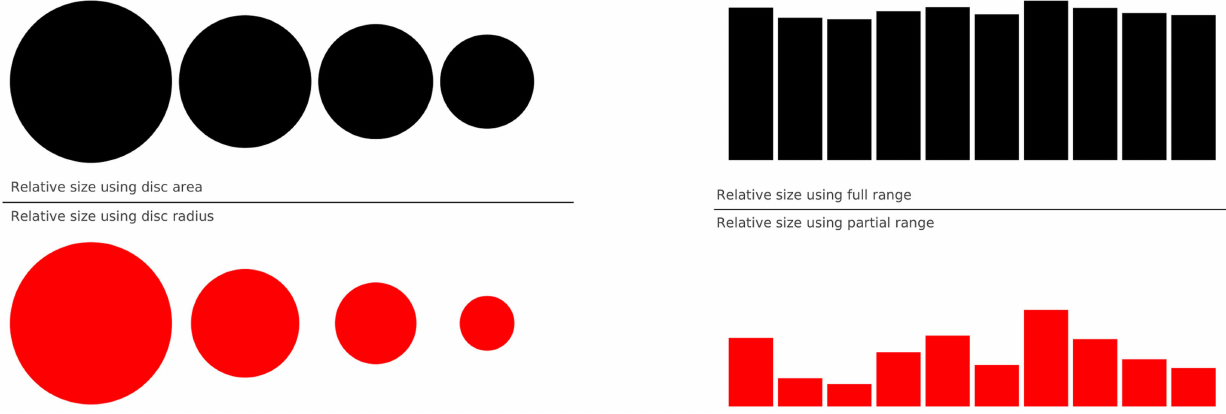
Figure 6. Do not mislead the reader. On the left part of the figure, we represented a series of four values: 30, 20, 15, 10. On the upper left part, we used the disc area to represent the value, while in the bottom part we used the disc radius. Results are visually very different. In the latter case (red circles), the last value (10) appears very small compared to the first one (30), while the ratio between the two values is only 3:1. This situation is actually very frequent in the literature because the command (or interface) used to produce circles or scatter plots (with varying point sizes) offers to use the radius as default to specify the disc size. It thus appears logical to use the value for the radius, but this is misleading. On the right part of the figure, we display a series of ten values using the full range for values on the top part (y axis goes from 0 to 100) or a partial range in the bottom part (y axis goes from 80 to 100), and we explicitly did not label the y-axis to enhance the confusion. The visual perception of the two series is totally different. In the top part (black series), we tend to interpret the values as very similar, while in the bottom part, we tend to believe there are significant differences. Even if we had used labels to indicate the actual range, the effect would persist because the bars are the most salient information on these